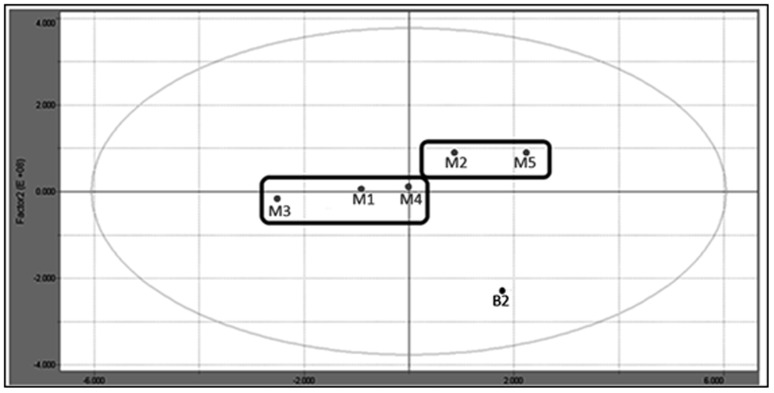
Analysis of lipids of E. coli DH5-α using FTIR and principal component analysis.Points M2 and M5: control without mesotrione (LB), in duplicate. Points M1, M3 and M4: treatment with mesotrione (LB+0.04 mM mesotrione) in triplicate. Point B2: negative control, Bacillus sp. in the absence of mesotrione.